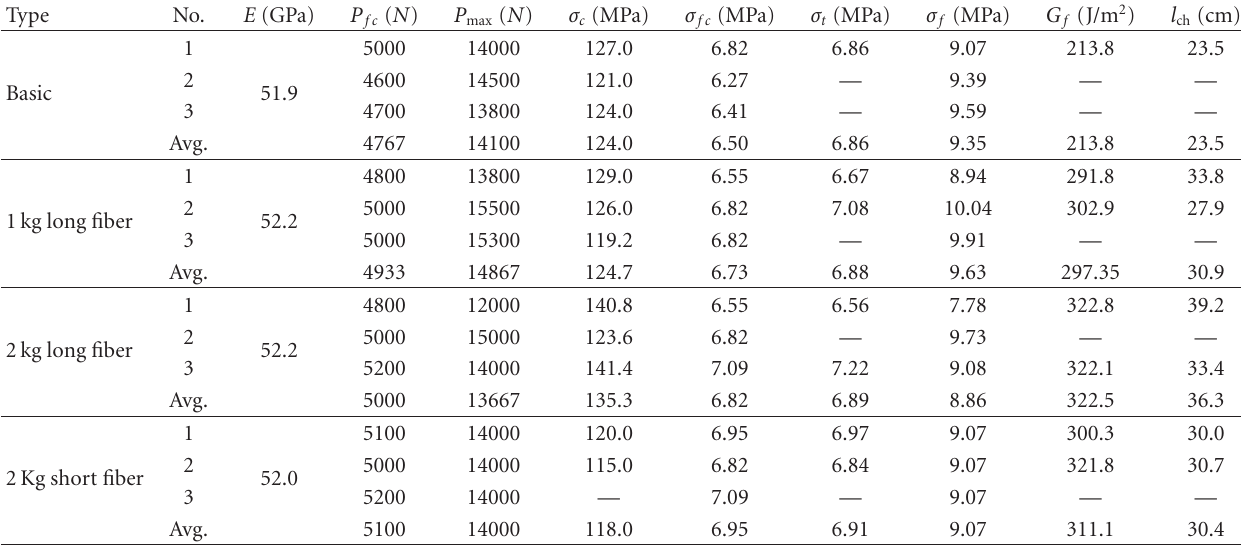
Table 4: Concrete fracture parameter test